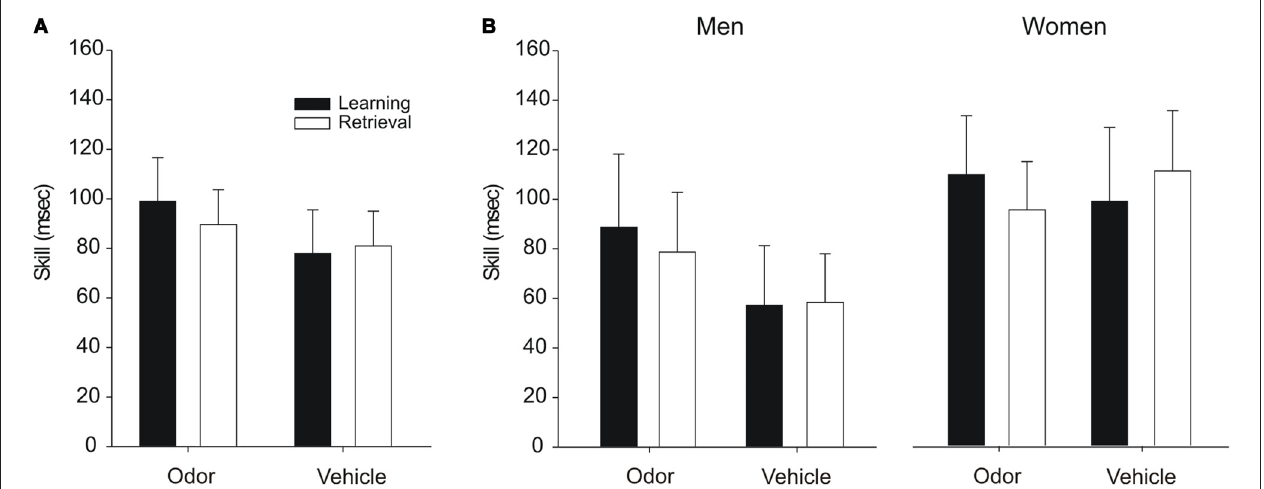
FIGURE 3 | Performance on the SRTT after odor reactivation during sleep. Odor presentation during SWS did not affect the skill level in the SRTT, neither in the whole sample (A) nor in men and women separately (B) . The skill level is presented as the difference between the last random trials and the preceding last sequence trials (in ms) at the end of learning (2nd test block) and at retrieval (3rd test block), respectively. Mean ± SEM are shown.